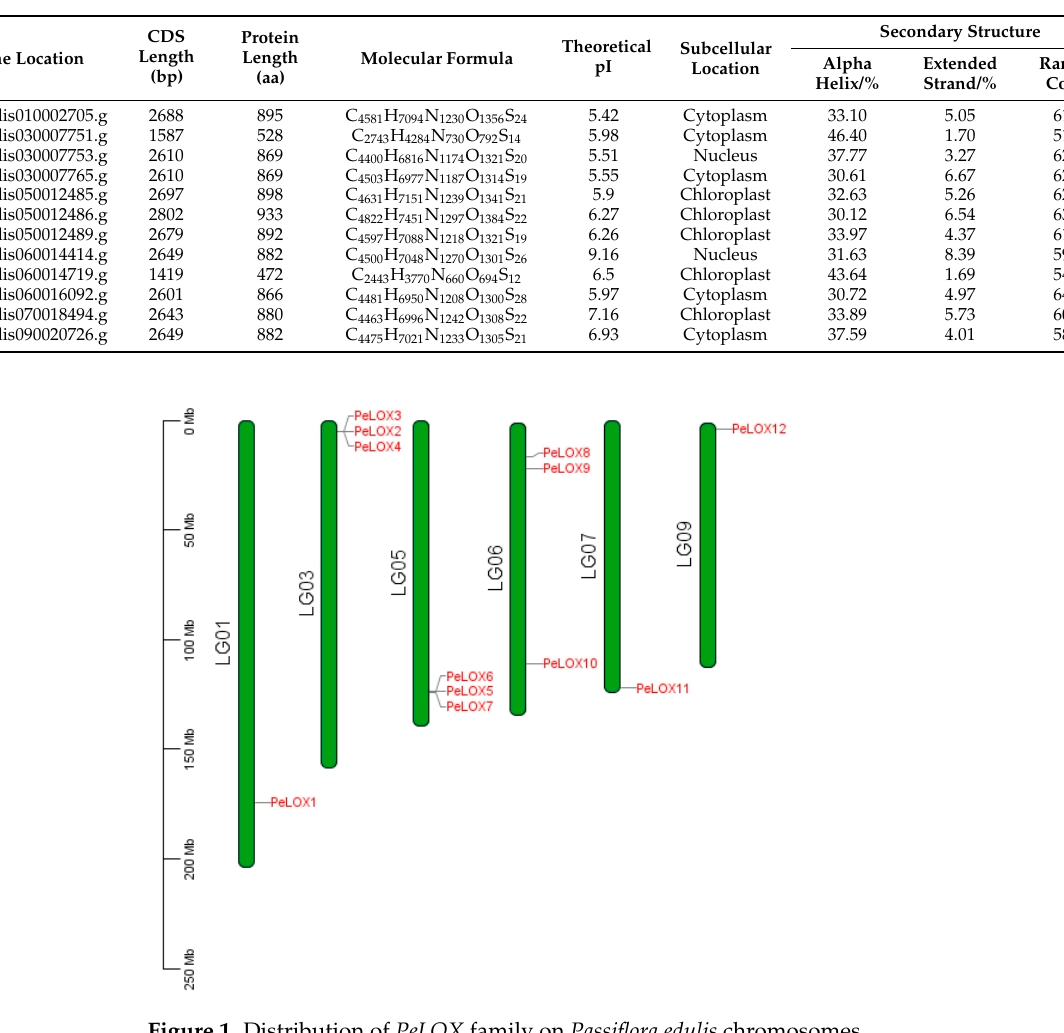
Table 1. The characteristics of 12 PeLOX members in Passiflora edulis .